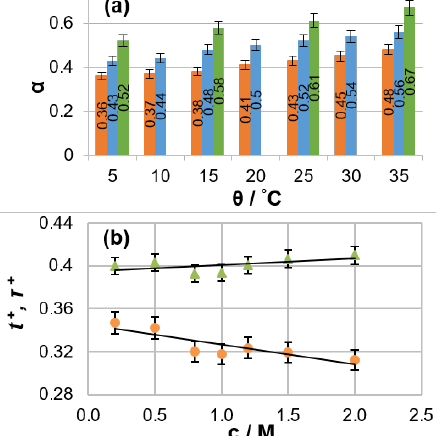
Figure 1. ( a ) Degree of ion pairing for 1 M LiPF 6 in various solvent mixtures as a function of temperature. Solvent components mixed as EC:DMC (7:3 v/v, brown), EC:DMC (1:1 v/v, blue), and EC:EMC (3:7 v/v, green), where EC, DMC, and EMC are ethylene carbonate, dimethyl carbonate and ethyl methyl carbonate respectively. ( b ) Salt concentration dependence of the cation transference number t + (brown circles) and transport number τ + (green triangles) in a 1 M LiPF 6 EC:DMC 1:1 v/v solution. (Reproduced with permission from [18]; Copyright 1948 Royal Society of Chemistry).